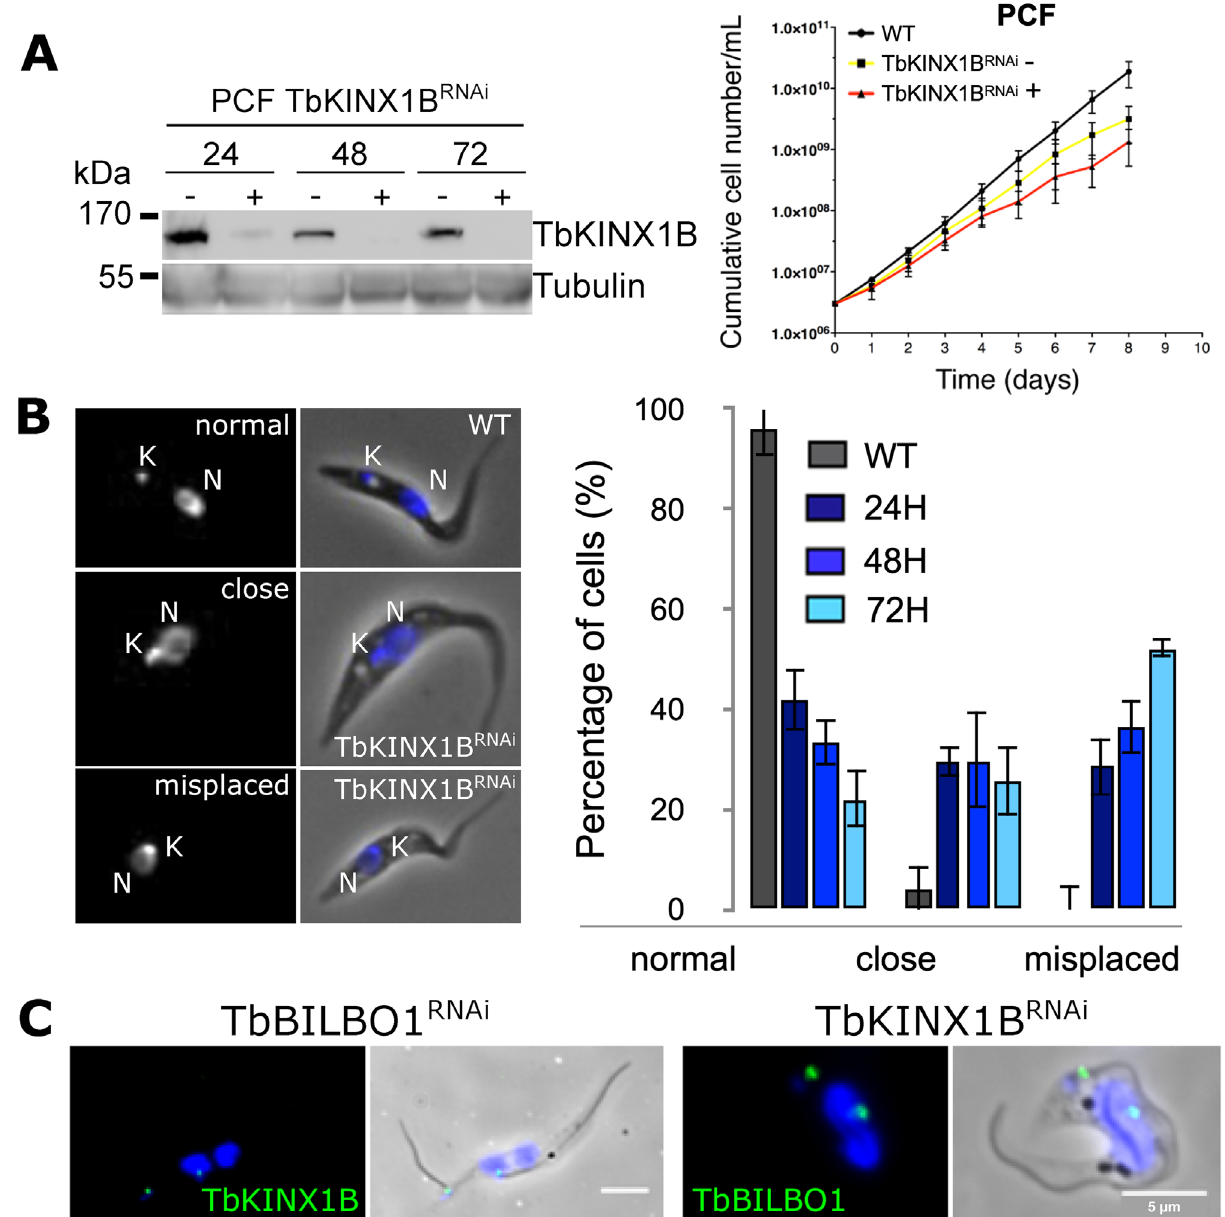
Figure 4. TbKINX1B is involved in basal body/FPC segregation in PCF . A. Left panel, Western blot analysis of whole cell protein extracts from PCF TbKINX1B RNAi cell line in the presence (+) or absence ( (cid:3) ) of tetracycline after 24 h, 48 h or 72 h probed with anti-TbKINX1B, anti-TbBILBO1, and anti-Tubulin (TAT1) as a loading control (left panel). Right panel, PCF growth curves showing that induction of RNAi down-regulation of TbKINX1B (TbKINX1B RNAi ) does not dramatically affect cell growth when compared to WT and non-induced cells ( n = 3). B. Down-regulation of TbKINX1B induces misplaced kinetoplasts. Left panel, IFA micrographs from CSK preparation of WT (a) and TbKINX1B RNAi cell lines after 48 h of induction (b, c). Kinetoplasts (K) and nuclei (N) were stained with DAPI. Right panel, quanti fi cation of kinetoplast localization in 1K1N WT cells and in TbKINX1B RNAi cells after 24 h, 48 h and 72 h of induction. C. Left panel, immunolocalization of TbKINX1B (green) in TbBILBO1 RNAi induced detergent-extracted cells. Right panel, immunolocalization of TbBILBO1 (green) in TbKINX1B RNAi induced detergent-extracted cells. Scale bars 5 l tetracycline-inducible RNA interference (RNAi) [3] (Fig. 4). Light microscopy observation of PCF WT and Immunoblotting con fi rmed that TbKINX1B protein levels were TbKINX1B RNAi cells after 24 h to 72 h knockdown revealed a small subset of the population with an abnormal number of kinetoplasts (K) or nuclei (N) and FPC, and/or with detached and multiple fl agella (Fig. S2A). In these cells, the absence of FAZ detection at the new detached fl agella suggests a FAZ